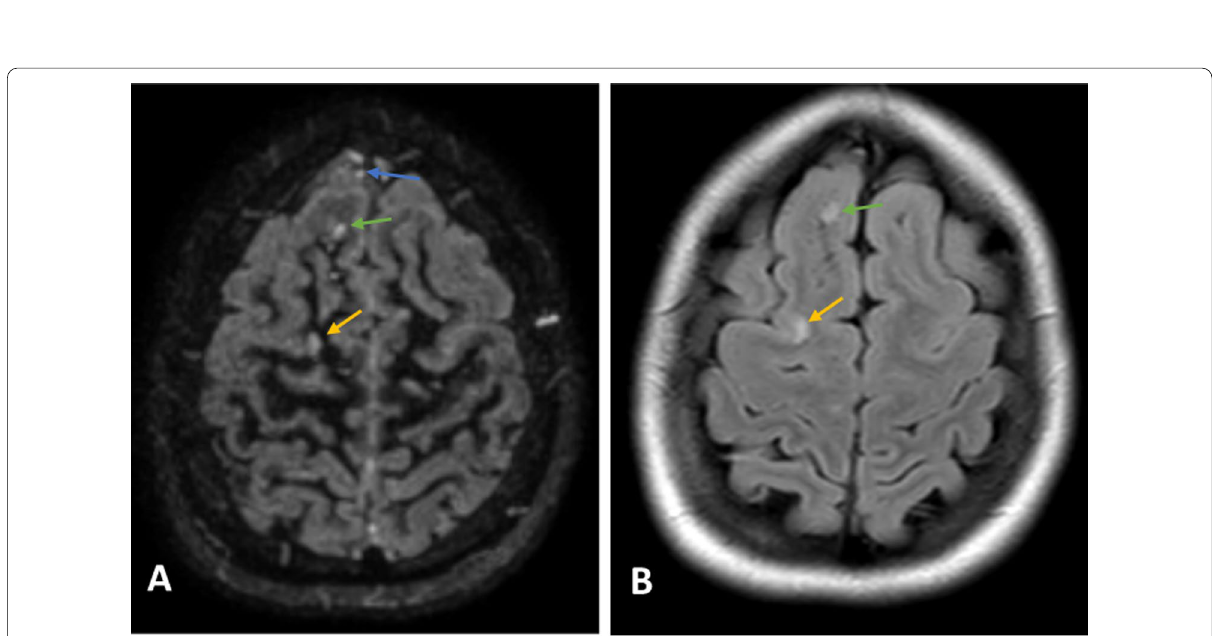
Fig. 4 A 31-year-old female patient with relapsing–remitting MS and EDSS score of 3. A Axial DIR revealed right frontal type 1 (orang arrow), type 2 (green arrow) and type 3 plaque (blue arrow) cortical plaques. B Axial FLAIR at the same level defines the type 1 and 2 cortical plaques but didn’t reveal the type 3 cortical